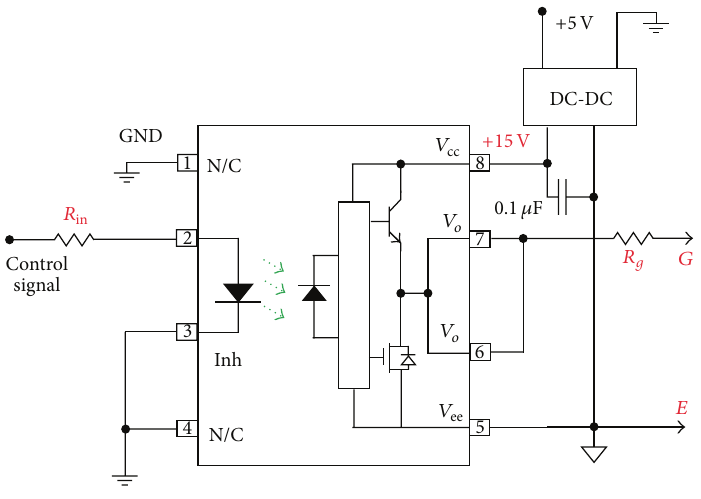
Figure 21: ACPL-312T IGBT driver